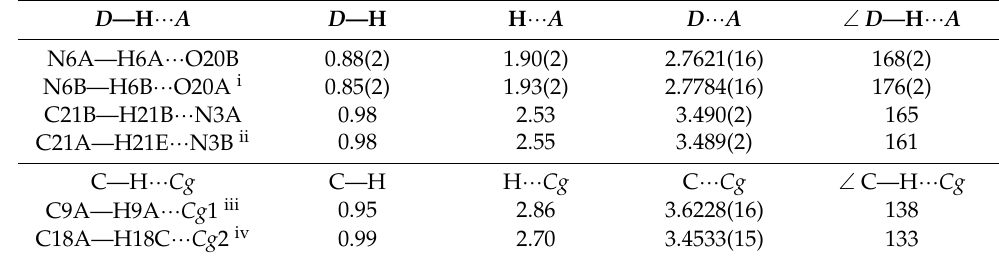
( b ) Figure 8. Two views of the unit cell ( a ) and ( b ) showing N ― H···O and C ― H···N hydrogen bonding and C ― H··· Cg intermolecular interactions in the crystal structure of 6 . The H atoms not involved in hydrogen bonds have been omitted for clarity; Cg 1 = thiazole system, Cg 2 = phenyl system. 2.2. Biological Evaluations 2.2.1. In Vitro Study of the Anticancer Activity in 60 Lines under the NCI DTP Screening For a preliminary assessment of the antitumor activity of pyridine-thiazoles, a screening study of the compounds 4 , 5 and 6 was conducted within the Developmental Therapeutic Program (DTP) by the National Cancer Institute (NCI, Bethesda, Rockville, MD, USA). Primary anticancer assays (Table 3) on a panel of 60 cancer cell lines at one dose-assay (10 − 5 M) were performed according to the NCI protocol, as described else- where [31–35]. The most active anticancer agent turned out to be compound 4 . It inhib- ited the growth of all 60 tested cancer cell lines by more than 50%, with the range of growth − 76.78–41.12%. Moreover, this compound showed not only a cytostatic effect, but also cytotoxic properties causing the death of cancer cells. Non-small cell lung cancer (NCI-H460, NCI-H522), melanoma (LOX IMVI, SK Mel-2), colon (Colo 205, HCT-15, HT29, KM12) and CNS (SF-539, U251) cancer cell lines were most sensitive to the action of compound 4 . Compared to the compound 4, parazoline-pyridine-thiazole hybrid molecules 5 and 6 showed moderate antitumor activity with a mean growth percent of about 50%. Therefore, the additional introduction of a pyrazoline fragment into the structure of the studied compounds leads to a certain loss of antitumor effect, which, nevertheless, is potentially interesting for the design of new anticancer molecules. Thus, the leukemic cells of CCRF-CEM, HL-60(TB), K-562, and SR lines, lung cancer cells of NCI-H522 line, melanoma MDA-MB-435 line, as well as breast cancer MDA-MB-468 line were the most sensitive to the action of the compound 5 . For compound 6 , a selectivity of antitumor ac-